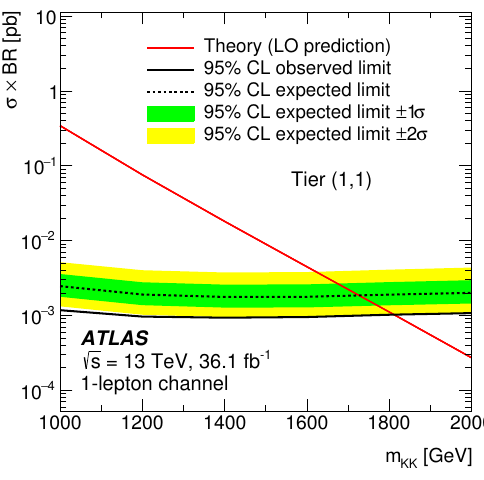
Figure 20. Observed (solid line) and expected (dashed line) 95% CL upper limits on the production cross section times branching ratio of four-top-quark events as a function of the Kaluza-Klein mass ( m KK ) from tier (1,1) in the symmetric case ( (cid:24) = R 4 =R 5 = 1). The background estimate used in the computation of the limits is the result obtained from the background-only (cid:12)t to data. The surrounding shaded bands correspond to 1 and 2 standard deviations around the expected limit. (cid:6) (cid:6) The thin red line shows the theoretical prediction, computed at LO in QCD, for the production cross section of four-top-quark events by tier (1,1) assuming ( A (1 ; 1) t (cid:22) t ) = 1, where the heavy B ! photon A (1 ; 1) is the lightest particle of this tier.